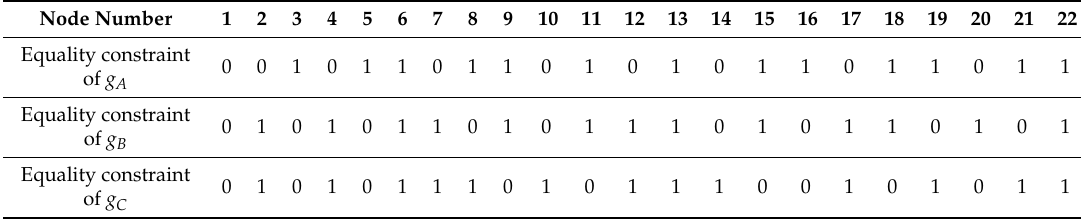
Table 5. Optimum placement of ATCTrs (solution C).